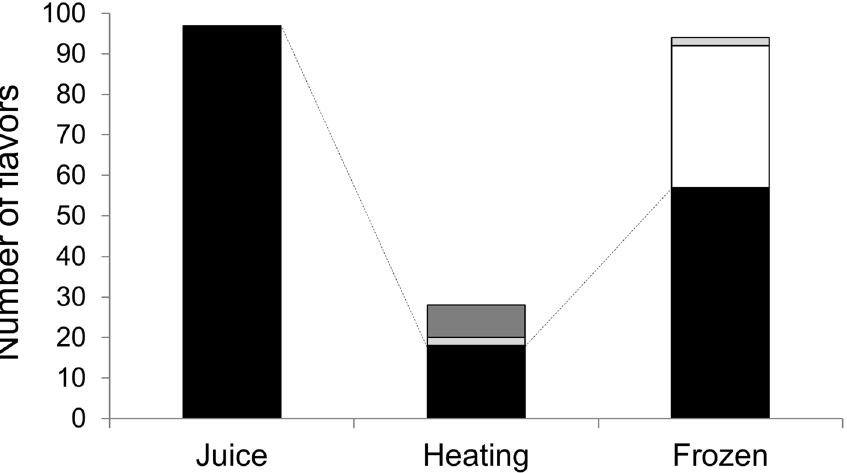
Figure 4. Numbers of flavors in each juice sample. Juice content (black), concentrated generated (light gray), frozen generated (white), and heating generated (dark